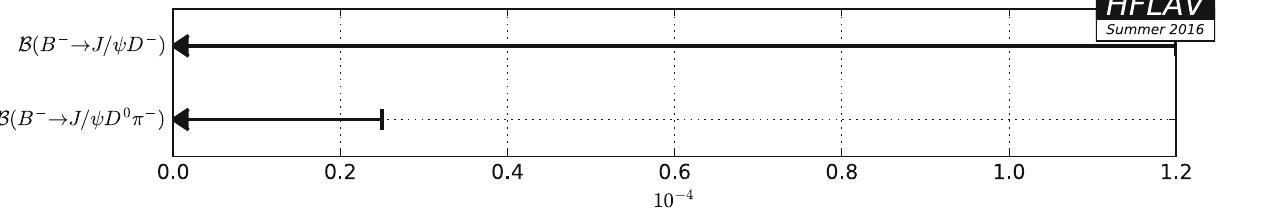
Fig. 134 Summary of the averages from Table 165